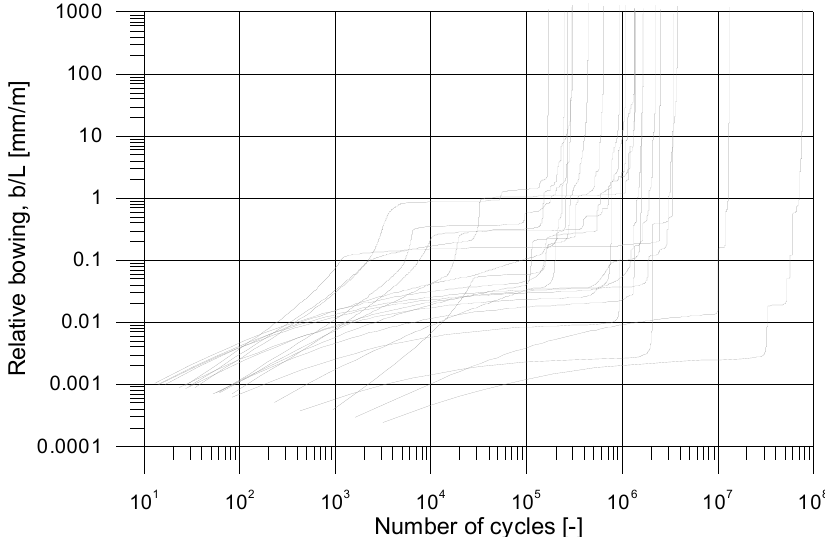
Figure 4: Relative bowing b/L vs number of cycles for 20 different realizations of grain orientation distribution along the slab thickness.